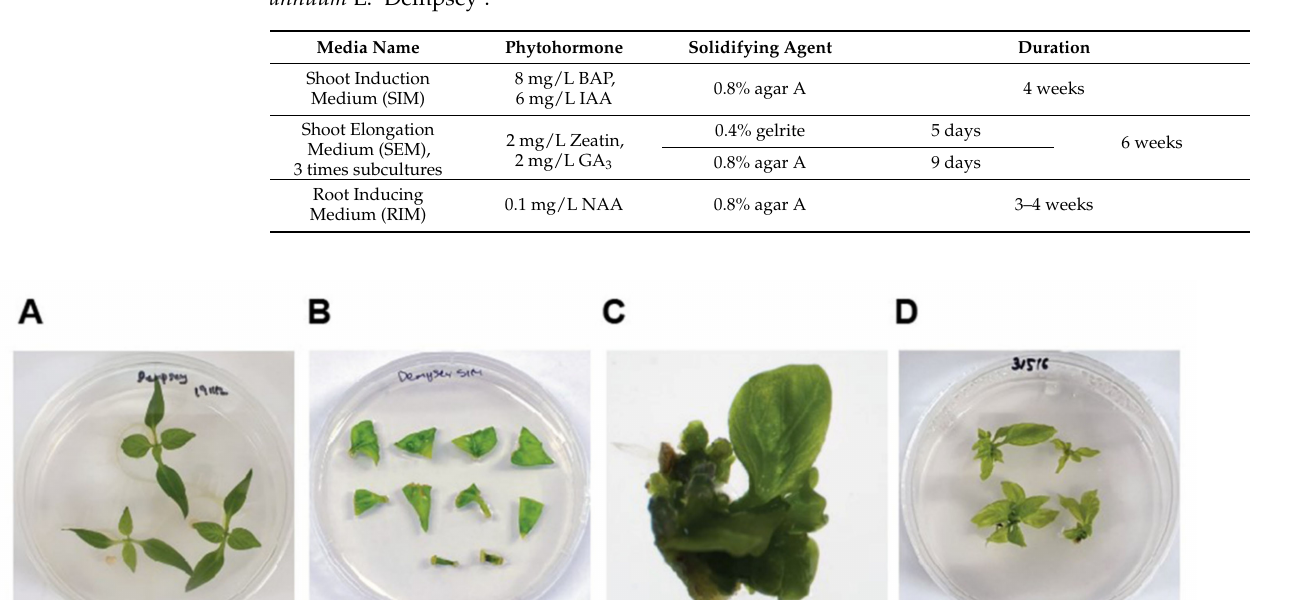
Table 1. Summary of media composition and duration of regeneration procedures in Capsicum annuum L. ‘Dempsey’.